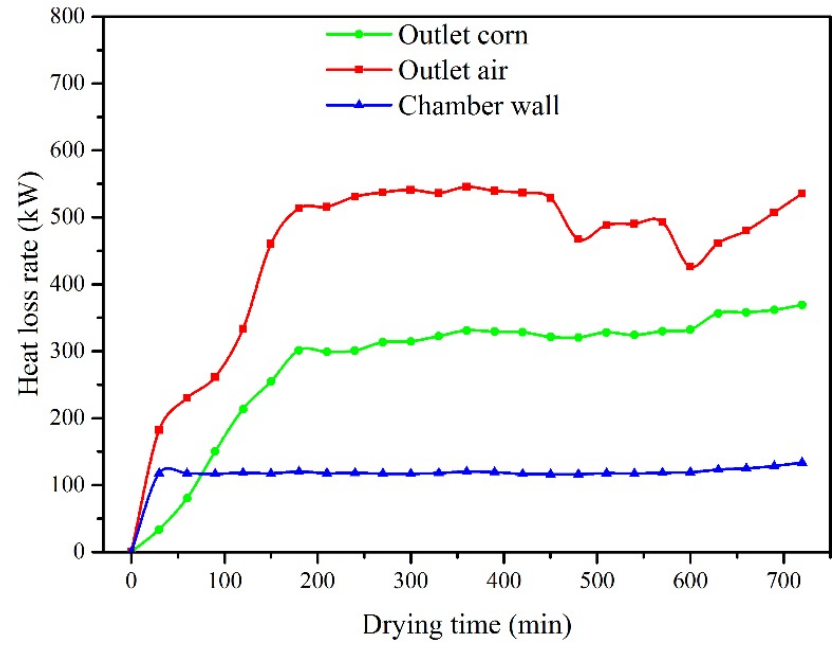
Figure 11. Variations of the heat-loss rate of the DC.